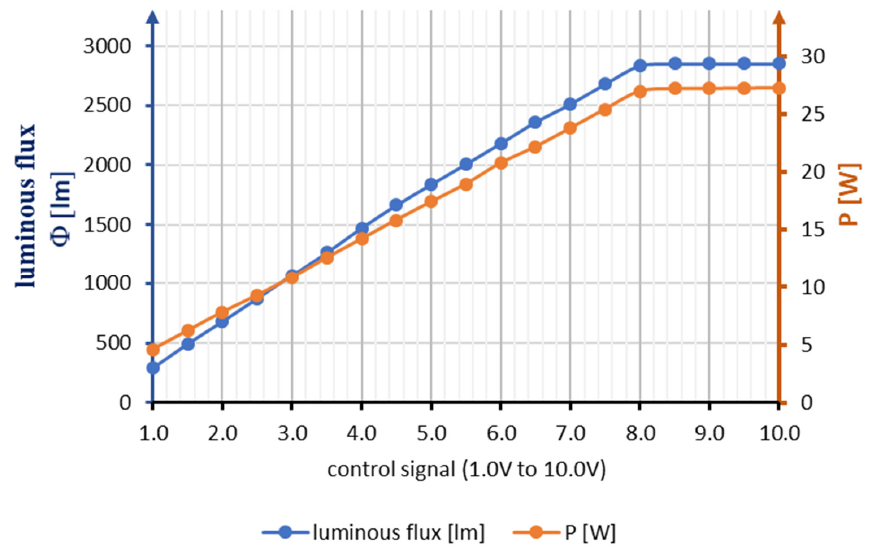
Figure 12. LED_26W luminaire control curve. Table 8. Overview of control levels for LED_26W luminaire in order to obtain the intended luminance levels. Average Lumi-